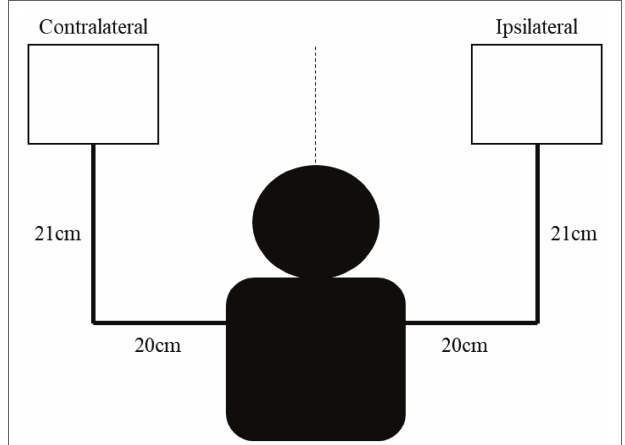
FIGURE 1 | Schematic representation of the Hand Selection Complexity Task. Here, a right-handed participant is seated at the midline with hands resting comfortably in front of them. An identical task gradient is positioned in contralateral and ipsilateral space, 20 cm laterally and 21 cm